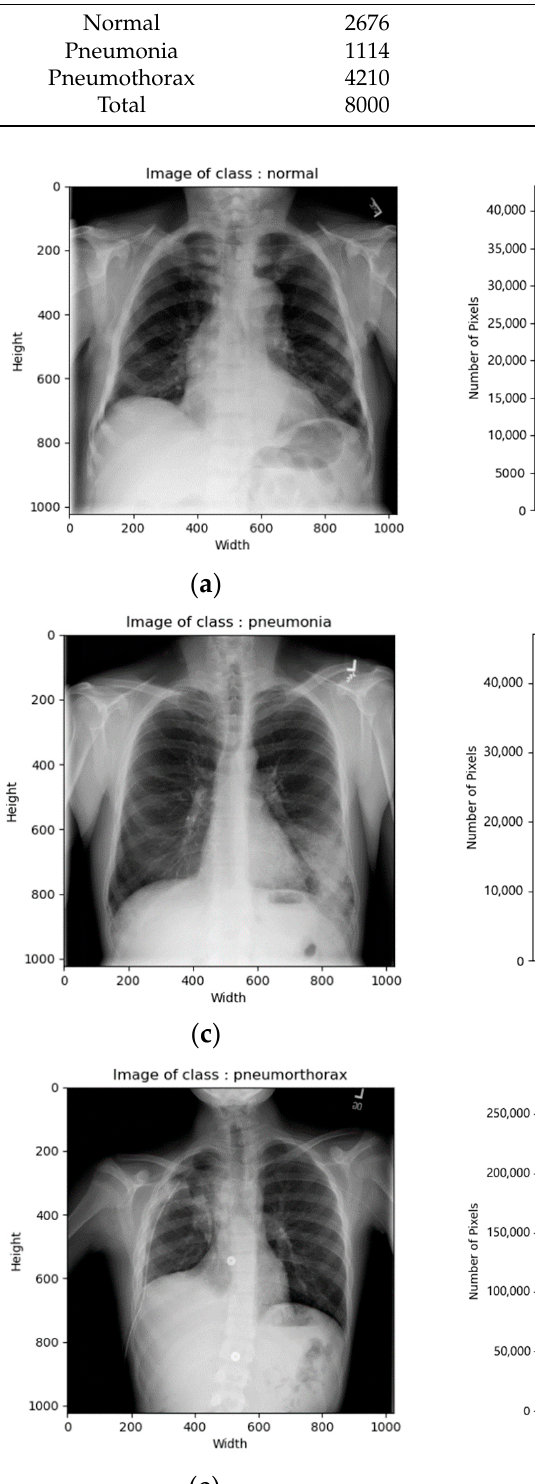
Figure 1. CXR images of NIH data set: ( a ) image of normal class; ( b ) histogram of normal class; ( c ) image of pneumonia class; ( d ) histogram of pneumonia class; ( e ) image of pneumothorax class; ( f ) histogram of pneumothorax class.